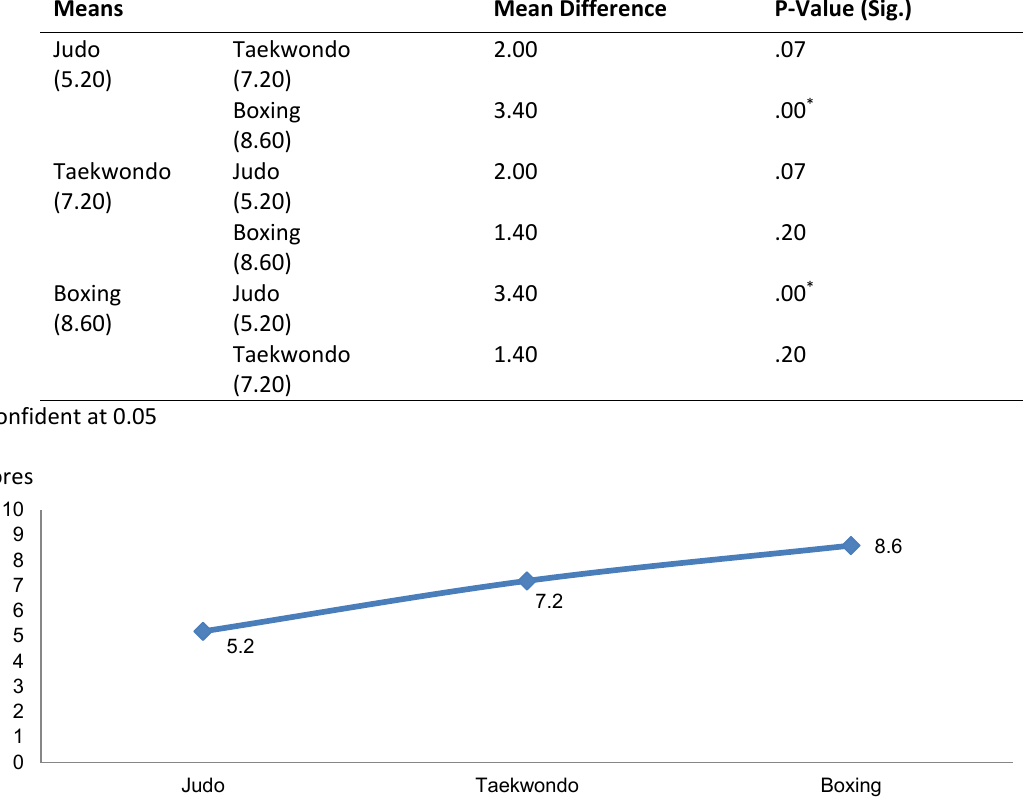
Table 18. Analysis of least significant difference (LSD) post-hoc test among judo, taekwondo and boxing players